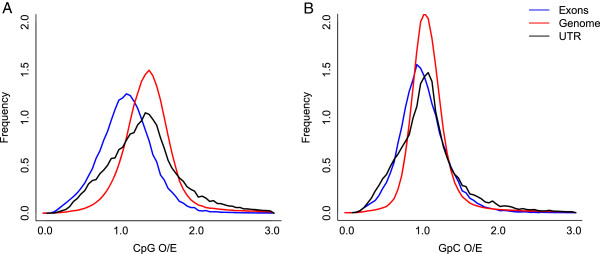
CpG Content in L. albipes. (A) Exons and mRNAs have lower CpG than expected, suggesting that gene bodies may be preferentially methylated in L. albipes, consistent with previous findings in A. mellifera. (B) GpC ratios were also calculated as a control. GpC dinucleotides have the same sequence composition as CpGs, but are not subject to biased mutation rates due to DNA methylation.